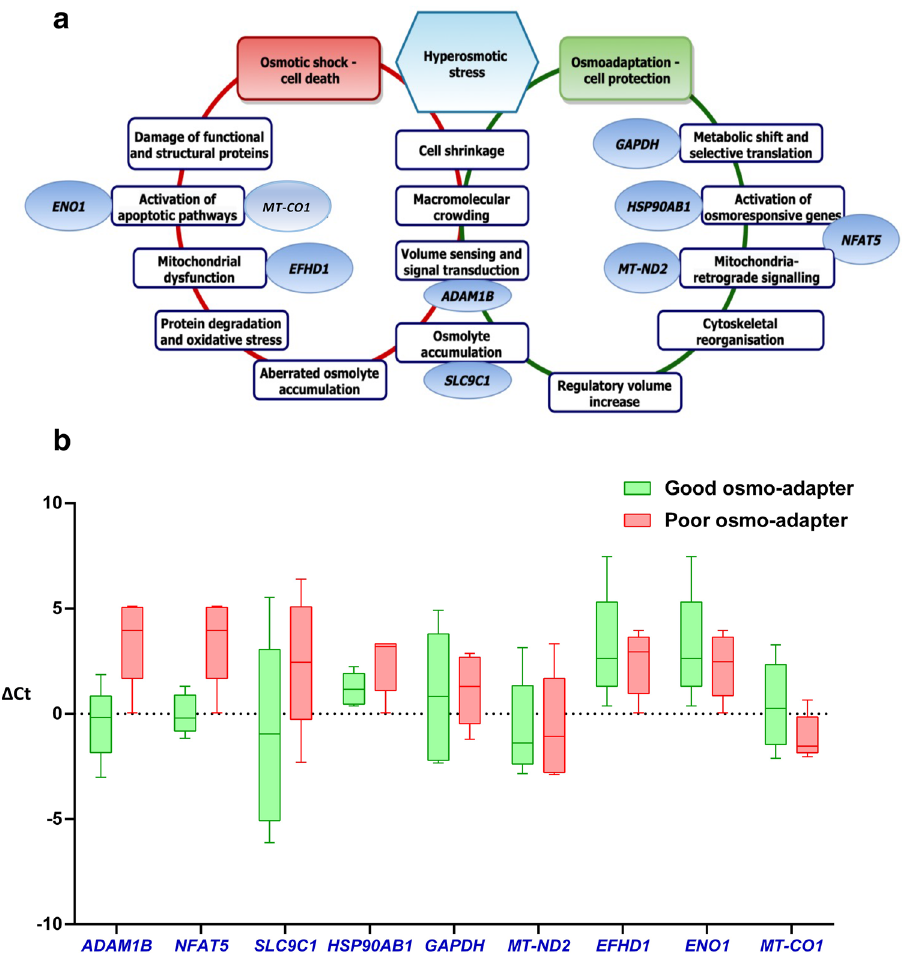
Figure 6. The osmo-responsive genes and their function pertaining to osmotic stress ( a ). The relative gene expression levels of osmo-responsive genes normalized to housekeeping gene RPL 23 (ΔCt) in good and poor osmoadapters ( b ). The relative expression levels of the genes NFAT5, and ADAM1B were significantly ( p < 0.05) higher in good osmo-adapter group as compared to poor